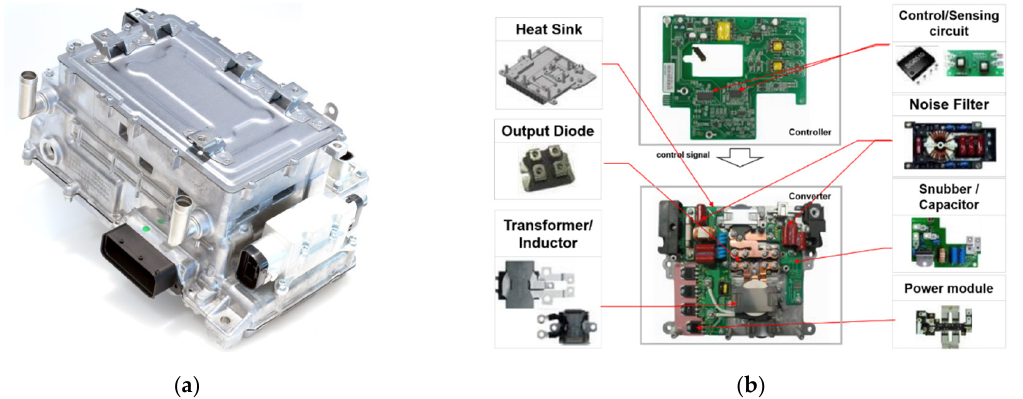
Figure 2. Pictures of power control unit (PCU) and LDC converter for vehicle applications. ( a ) PCU. ( b ) LDC.